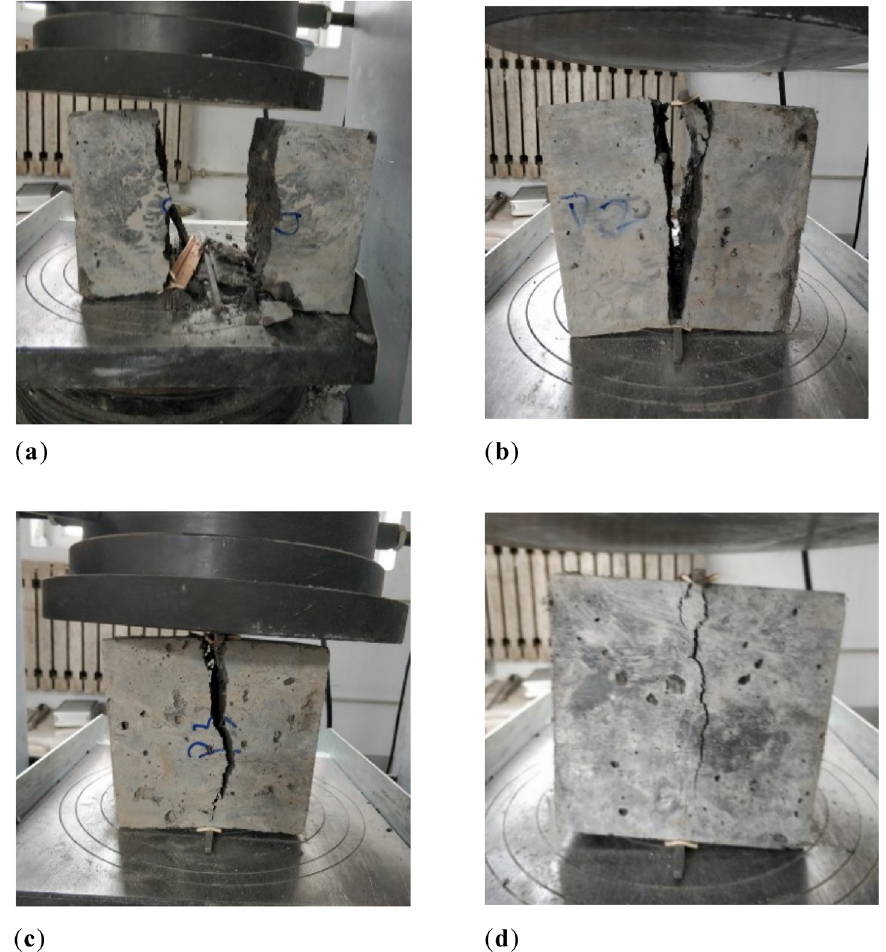
Figure 16: Splitting tensile failure patterns of specimens: ( a ) without PVA fi ber, ( b ) 0.4% PVA fi ber content, ( c ) 0.6% PVA fi ber content, and ( d ) 1.0% PVA fi ber